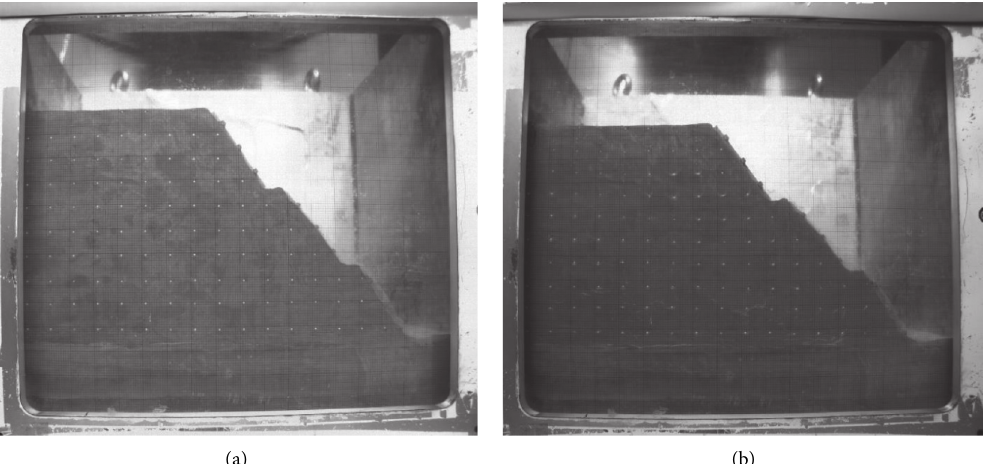
Figure 8: High-resolution images taken by the centrifuge. (a) High-resolution image at the beginning of the test. (b) High-resolution image at an acceleration of 80 g.